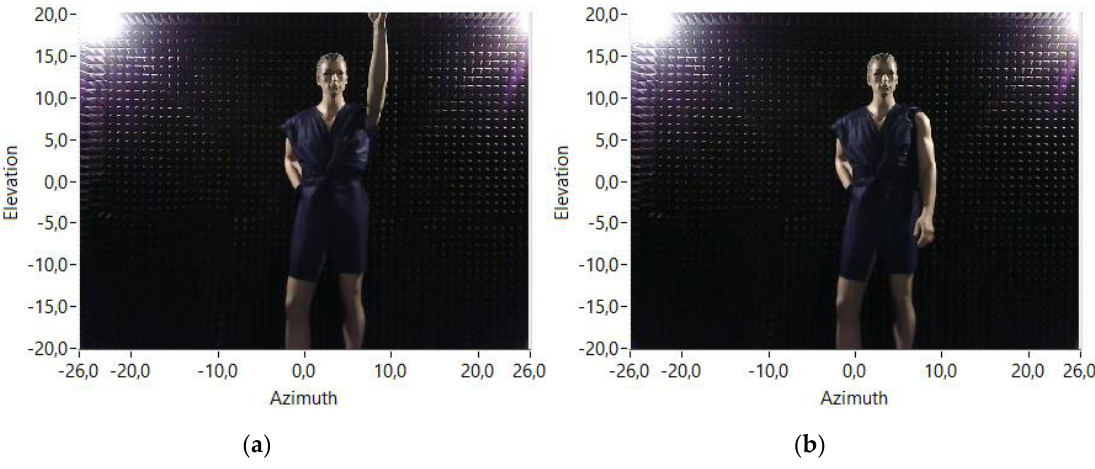
Figure 10. Mannequin positions: ( a ) arm up; and ( b ) arm down.